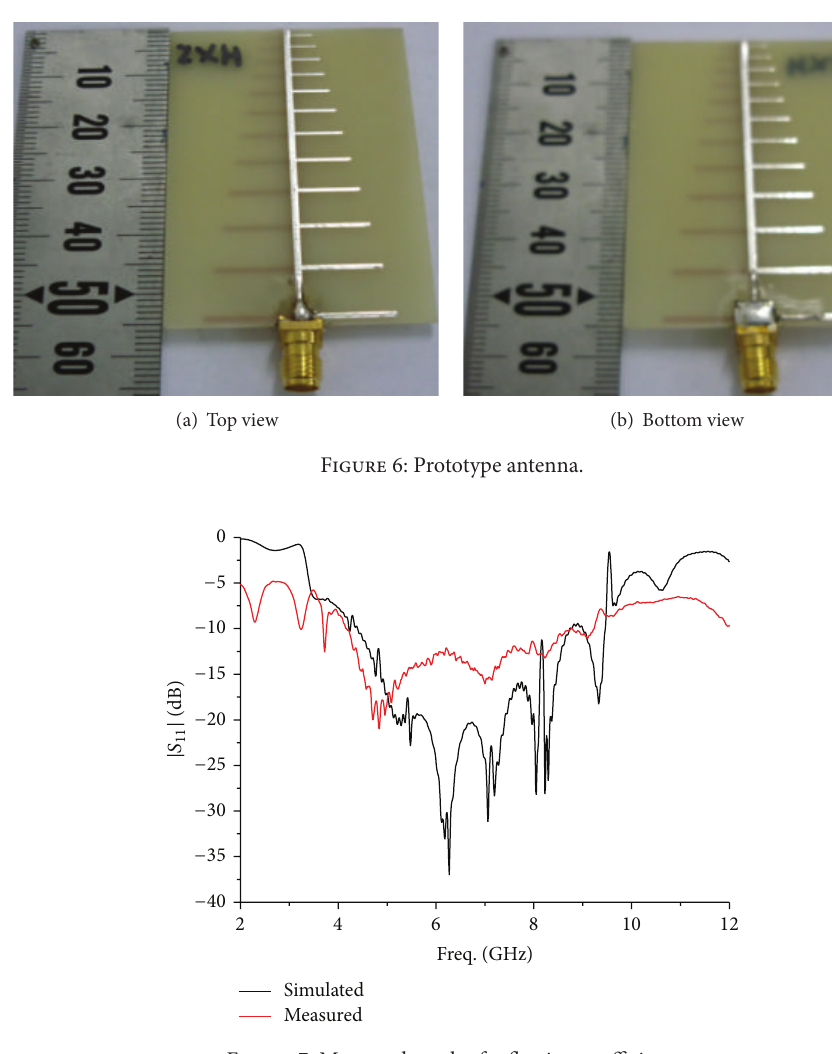
Figure 7: Measured result of reflection